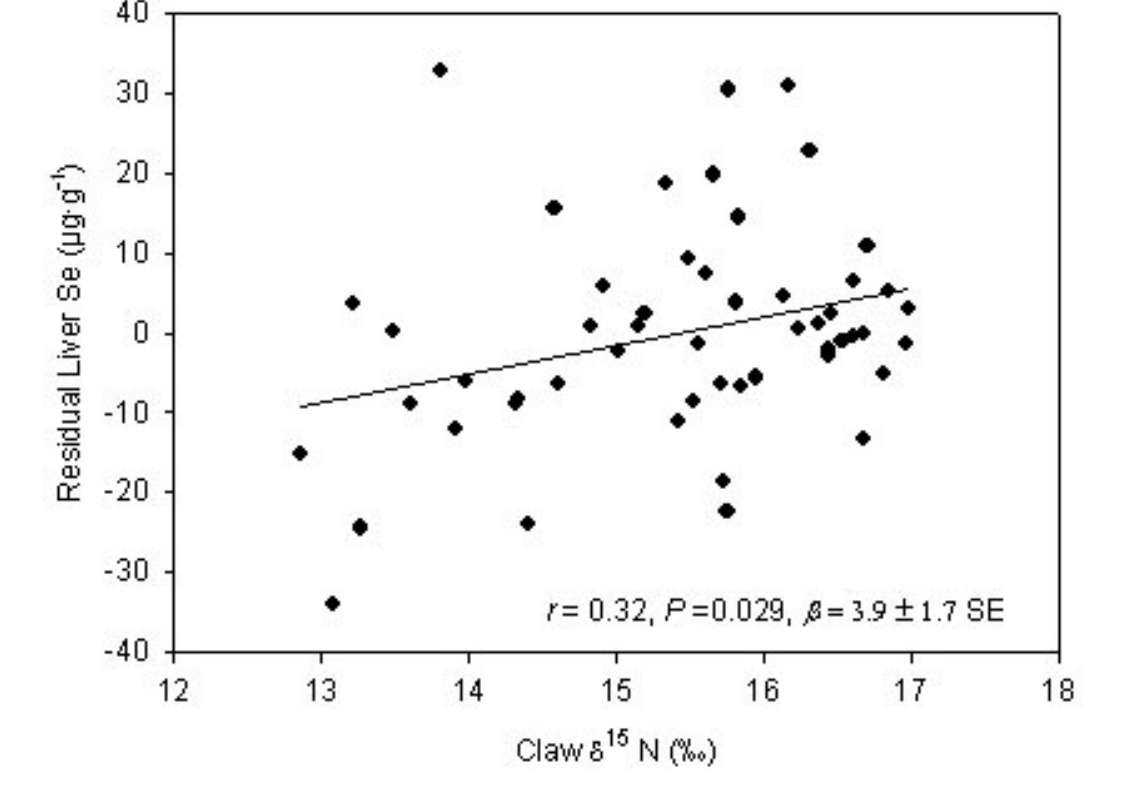
Fig. 1. Plot of claw tip d 15 N vs. residuals of liver selenium (Se) concentration, corrected for effect of collection date, and partial correlation